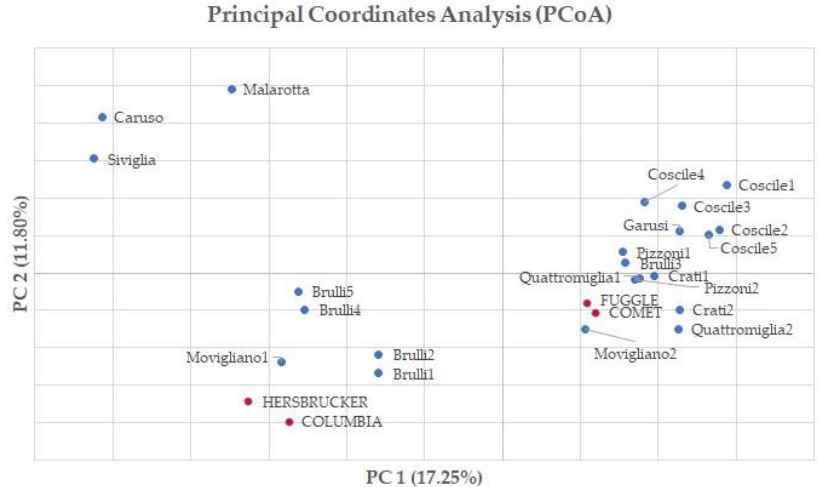
Figure 4. A two-dimensional plot of Principal Coordinate Analysis (PCoA) based on Fst genetic distance showing the clustering of hops genotypes (in red: commercial varieties). Table 6. Analysis of molecular variation (AMOVA) among and within three Calabrian hops populations. Source df SS MS Est. Var. Among Pops.